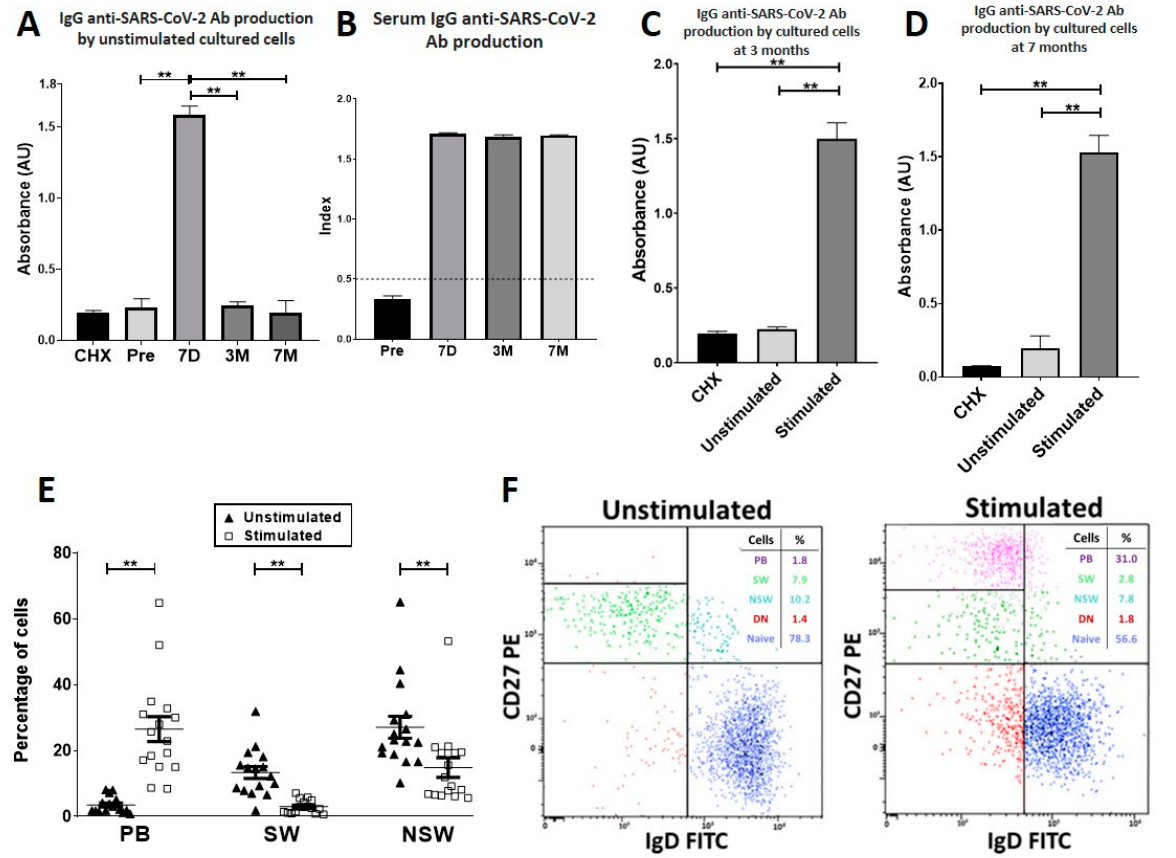
Figure 3. Specific anti-SARS-CoV-2 Ab responses. ( A ). IgG anti-SARS-CoV-2 Ab production in unstimulated enriched B-cell cultures before the first dose of the vaccine (Pre) and seven days (7D), three months (3M) and seven months (7M) after the second dose of the vaccine. IgG anti-SARS-CoV-2 Ab production in cultures with CHX at seven days. ( B ). Serum IgG anti-SARS-CoV-2 Ab levels were determined by ELISA. The results are reported as indices. Values above 0.5 were considered positive. ( C , D ). IgG anti-SARS-CoV-2 Ab production by cultured enriched B cells at three months ( C ) and seven months ( D ) after the second dose of the vaccine. Stimulated cultures contained a mixture of stimulating anti-CD40 mAb, IL-21 and BAFF. ( E ). B-cell subpopulations in cultures three months after the second dose of the vaccine. Cells collected after the culture period were analysed by flow cytometry. ** p < 0.001, Wilcoxon test for paired samples. PB were gated as CD19 low CD20-CD27 high CD38 high (purple); naive B cells were gated as CD19+CD20+IgD+CD27- (dark blue); SW-MBC were gated as CD19+CD20+IgD-CD27+ (green); NSW-MBC were gated as CD19+CD20+IgD+CD27+ (light blue) and DN cells were gated as CD19+CD20+IgD-CD27- (red) (n = 16). The results are expressed as the mean ± SEM of 16 independent experiments. ( F ). Representative dot plots of B-cell subpopulations in both unstimulated and stimulated cultures three months after the second dose of the vaccine are shown. Ab: antibodies; CHX: cycloheximide; IgG: immunoglobulin G; DN: double negative B cells; mAb: monoclonal antibody; NSW-MBC: nonswitched memory B cells; PB: plasmablasts; SW-MBC: switched memory B cells.